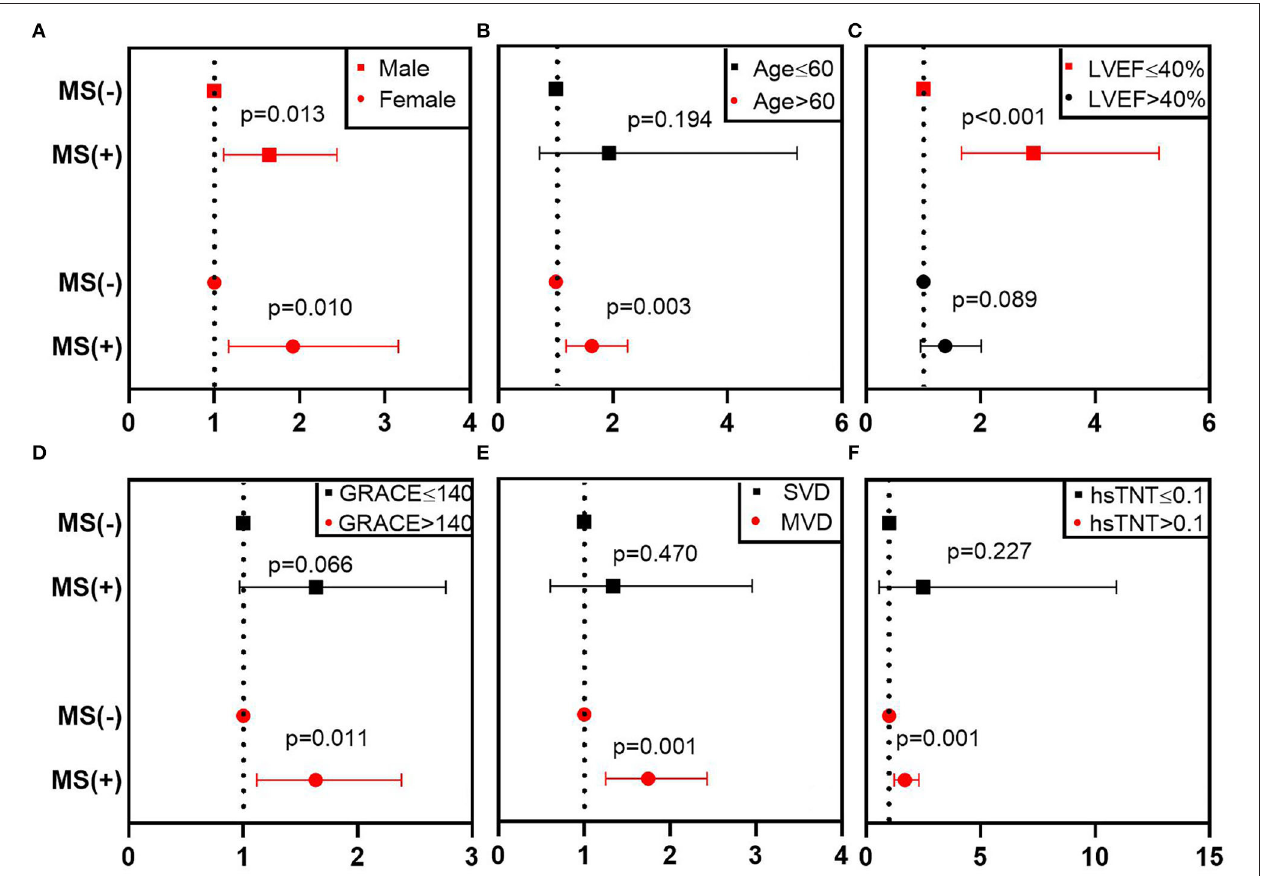
FIGURE 3 | Subgroup analysis of MS on MACE in different patients. This figure shows the adjusted HR (95% CI) of the subgroup analysis from the multivariable Cox model. (A–F) Represent the subgroups according to different gender, age, LVEF, GRACE, number of stenosis vessels, hsTNT. The red line denotes a statistically significant subgroup. CI, confidence interval; GRACE, Global Registry of Acute Coronary Events; hsTnT, hypersensitive troponin T; HR, hazard ratio; LVEF, left ventricular ejection fraction; MACE, major adverse cardiovascular events; MS, metabolic syndrome; MVD, multivessel disease; SVD, single-vessel disease.